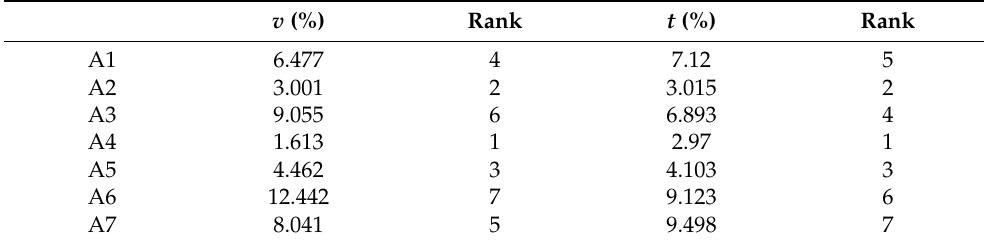
Table 13. Ranks of alternatives when using simulation software.